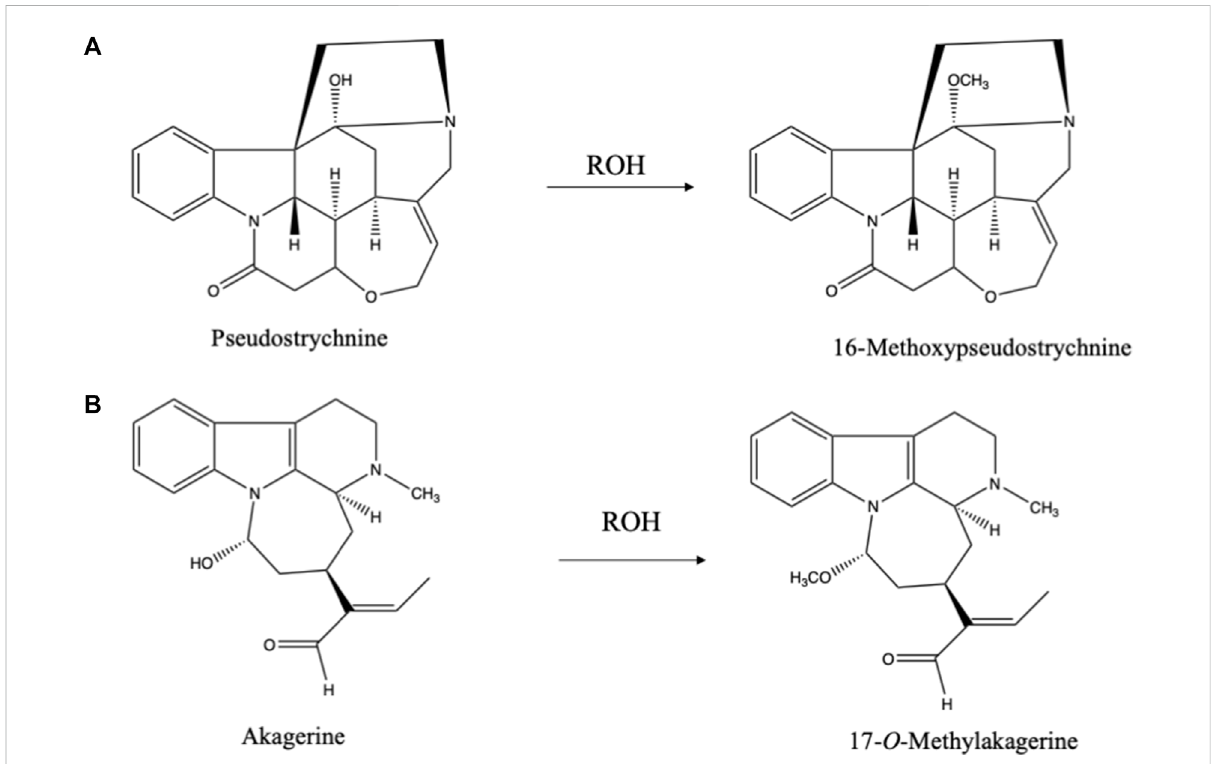
FIGURE 4 (A) Artifactsformedduringisolationofpseudostrychnineinalcoholicsolvent(Bissetetal.,1965). (B) Artifactformedduringisolationofakagerine in alcoholic solvent (Rolfsen et al.,